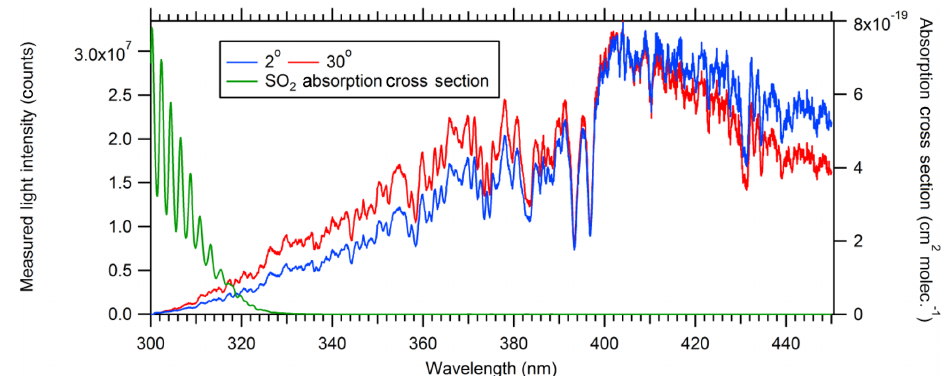
Figure 4. Comparison of the measured spectral intensity for the 2 and 30 ◦ viewing elevation angle spectra with the lower concentration cell without the short-pass filter, and the absorption cross section of SO 2 smoothed to the spectral resolution of the